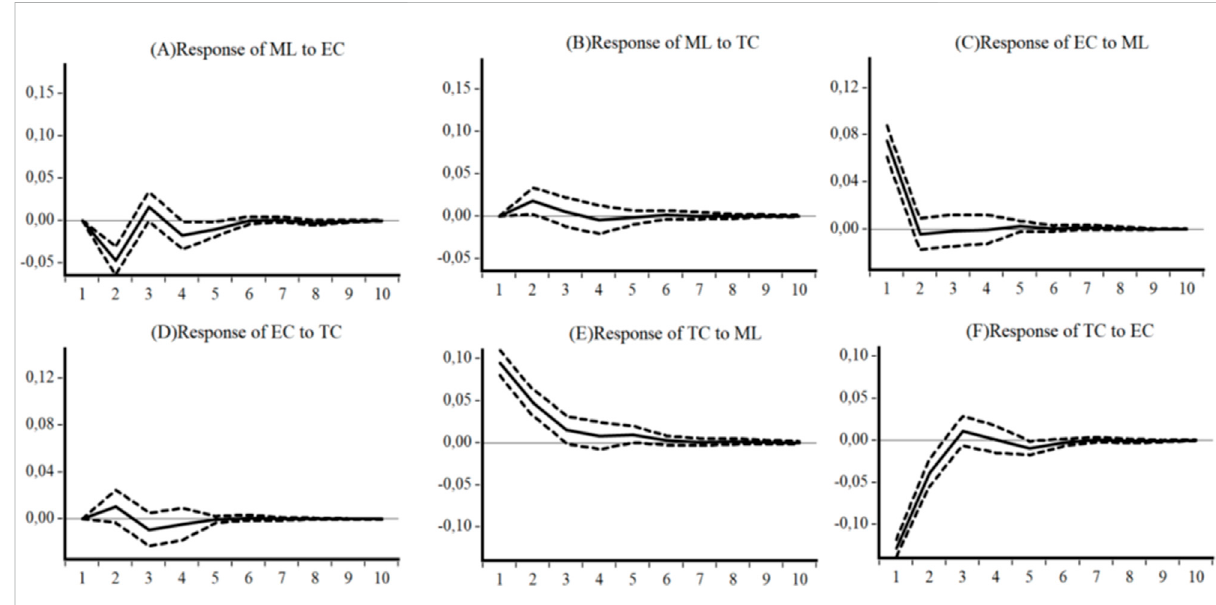
FIGURE 7 Impulseresponsesof ML , EC ,and TC ,China. (A) ResponseofMLtoEC, (B) ResponseofMLtoTC, (C) ResponseofECtoML, (D) ResponseofEC to TC, (E) Response of TC to ML, (F) Response of TC to EC.